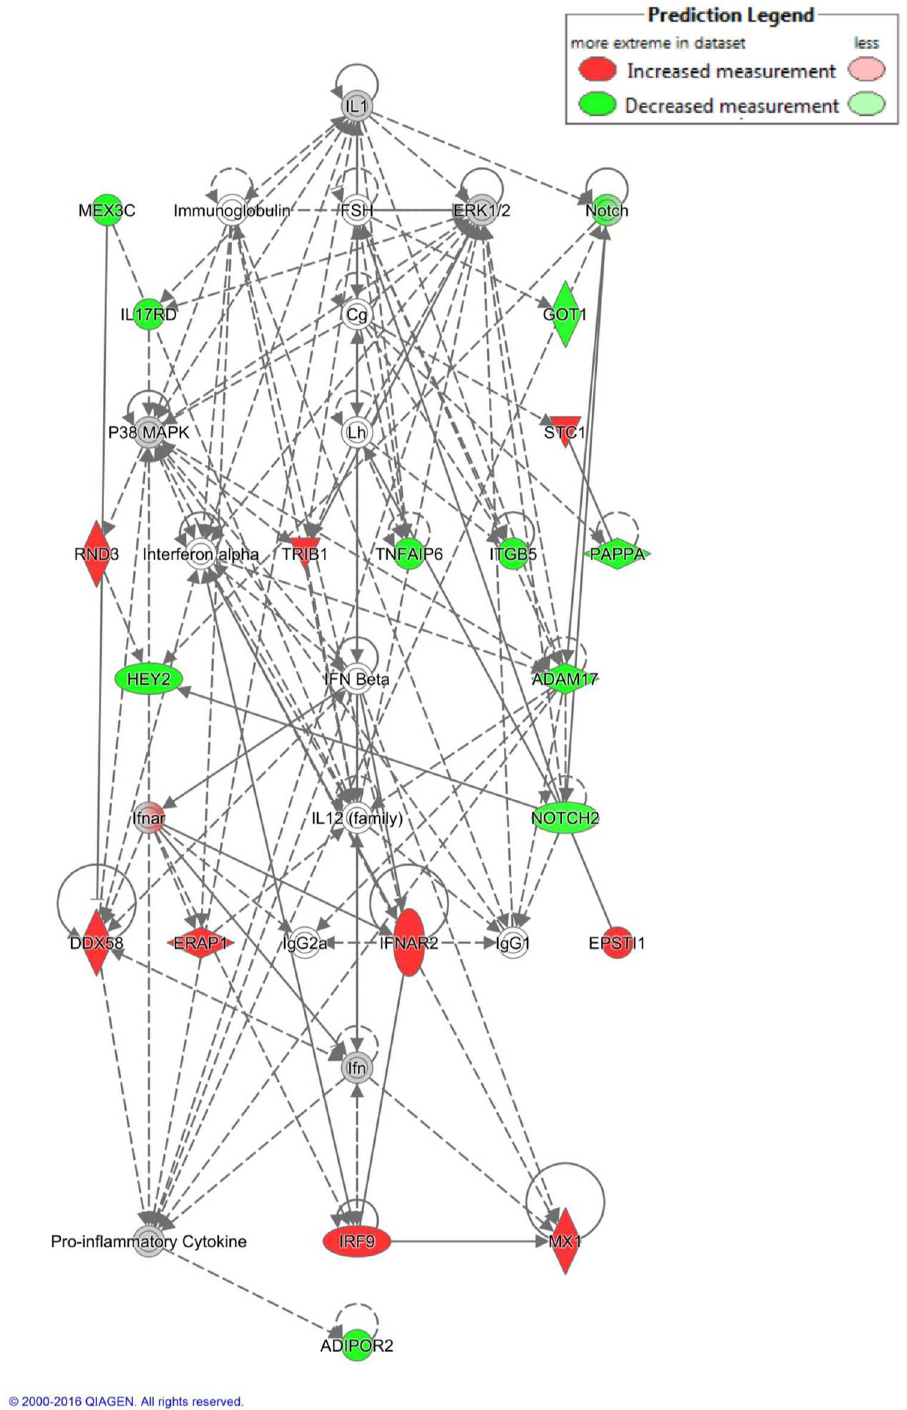
Fig 4. Network of interaction generated by IPA ® from the list of genes correlated with BL rate, organized by hierarchical structure. Node shapes represent functionalclasses; concentriccircles for groupsor complexes, vertically diamonds for enzymes, horizontallydiamondsfor peptidase,horizontally ellipsesfor transcriptional regulatorsor modulators, vertically ellipses for transmembrane receptor, inverted trianglesfor kinase and circles for